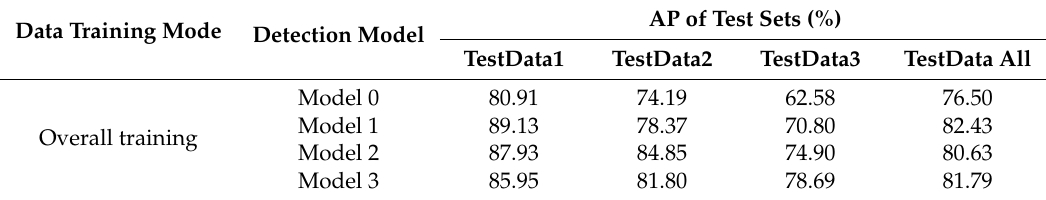
Table 12. Test results of test sets under overall training mode.